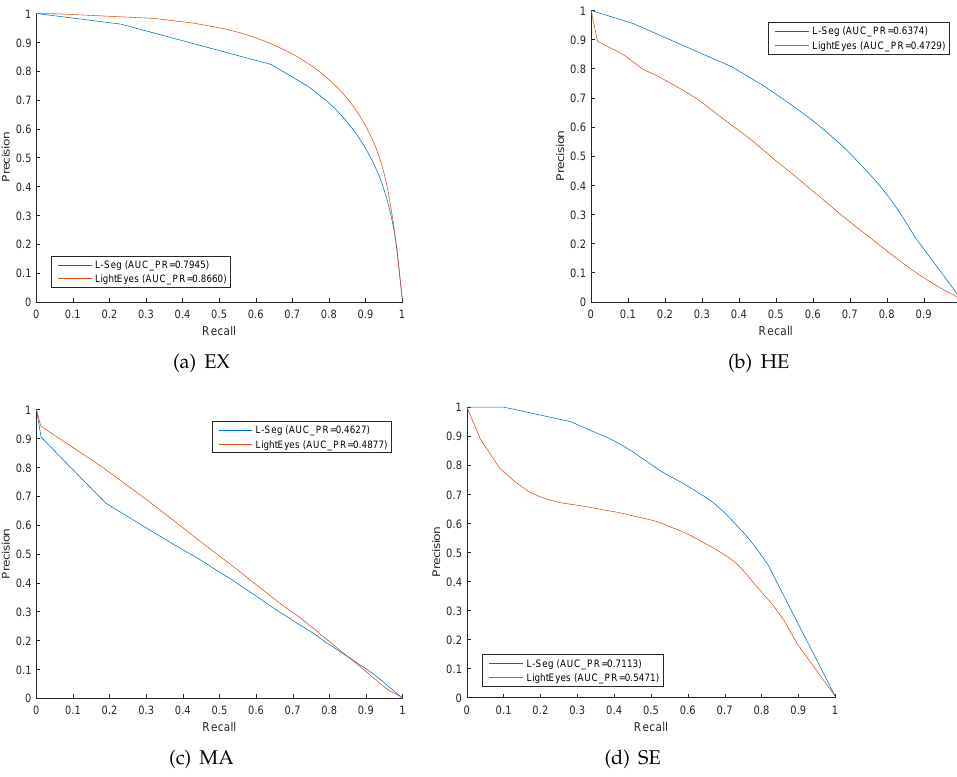
Figure 5. P–R curves for hard exudate (EX), hemorrhage (HE), microaneurysms (MA), and soft exudate (SE) on IDRiD